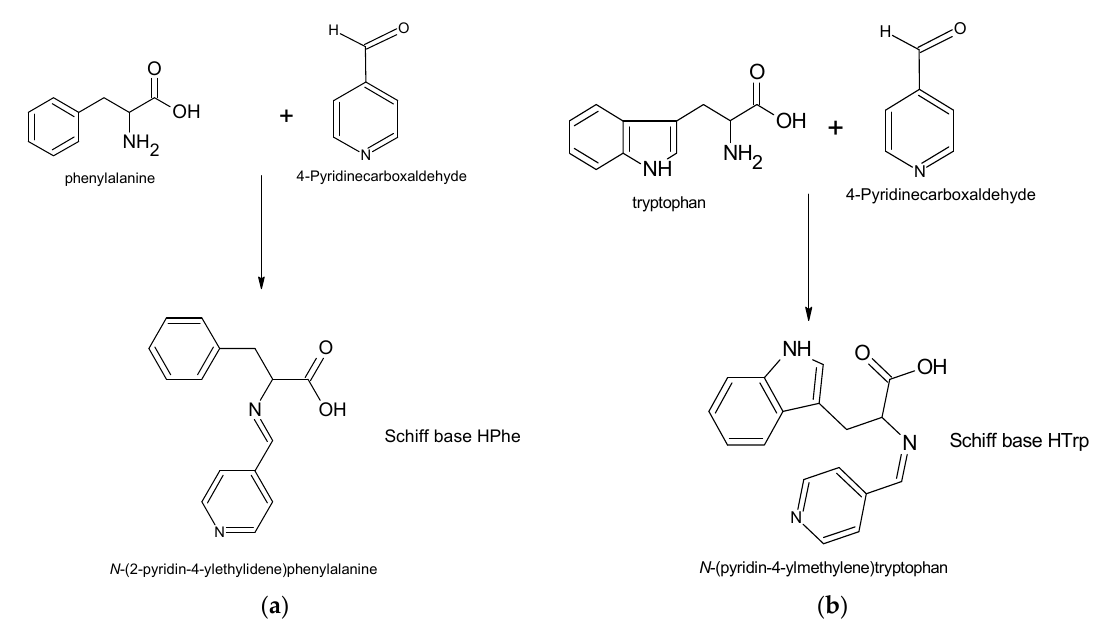
Figure 1. Synthesis pathway and structure of the Schiff base ligands: ( a ) HPhe obtained with L -phenylalanine, and ( b ) HTrp obtained with tryptophan.